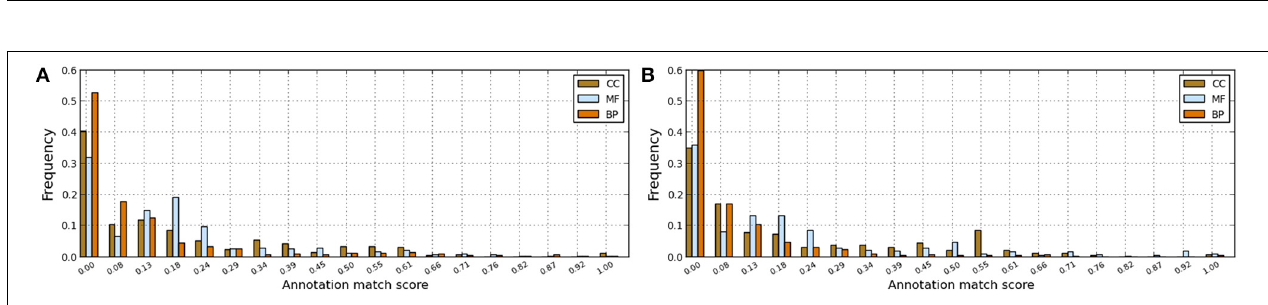
FIGURE 2 | Comparison of annotations inferred manually and electronically in human and fruitfly genomes in terms of annotation consistency score computed using the GO-universal metric. (A) Human genome. (B) Fruitfly genome.